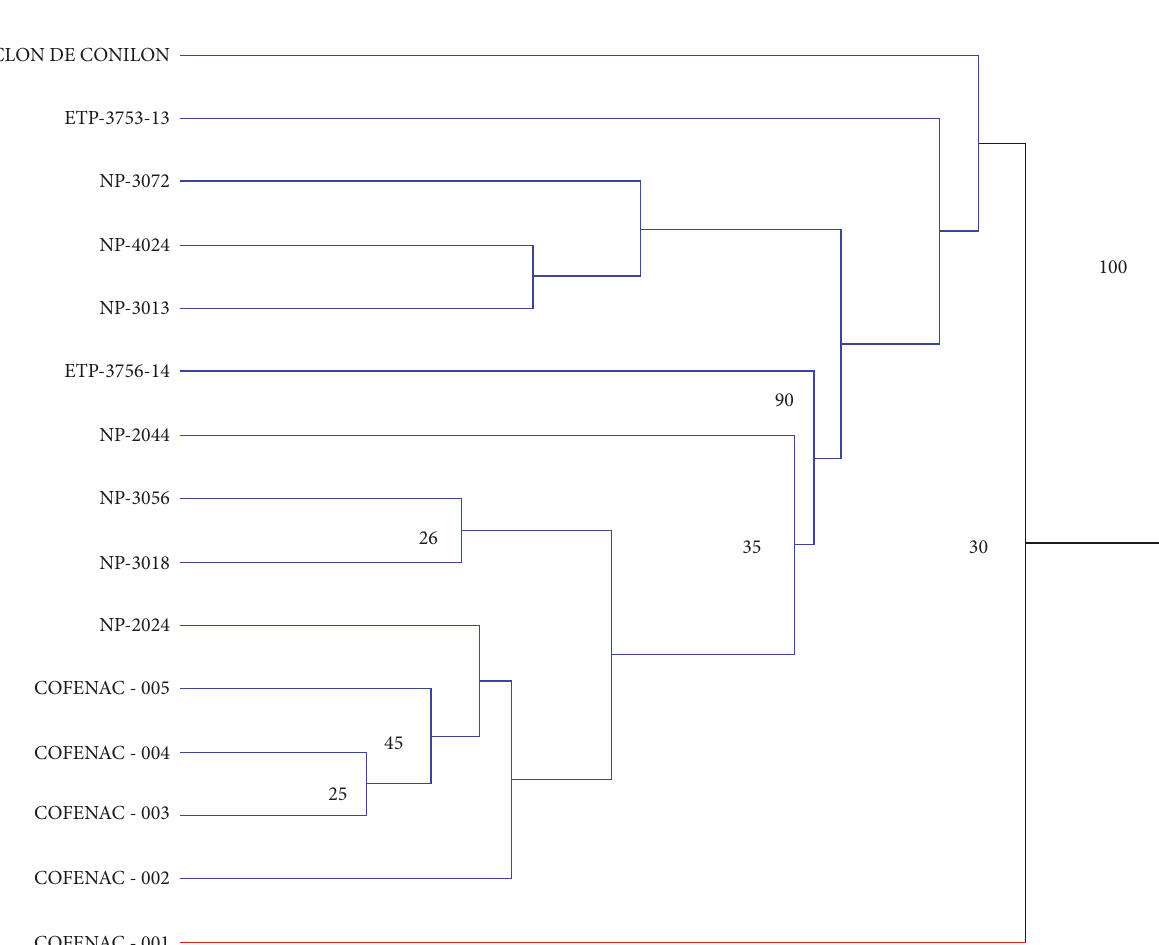
Figure 6: Phenotypic dendrogram for 16 accessions at EETP C. canephora collection. The data were collected between 2010 and 2012 using vigor traits (productivity, stem diameter, plant height, number of branches, number of nodes, and internode length). Branch support is expressed in percent of presence after 10000 bootstraps (values above 0.2 are